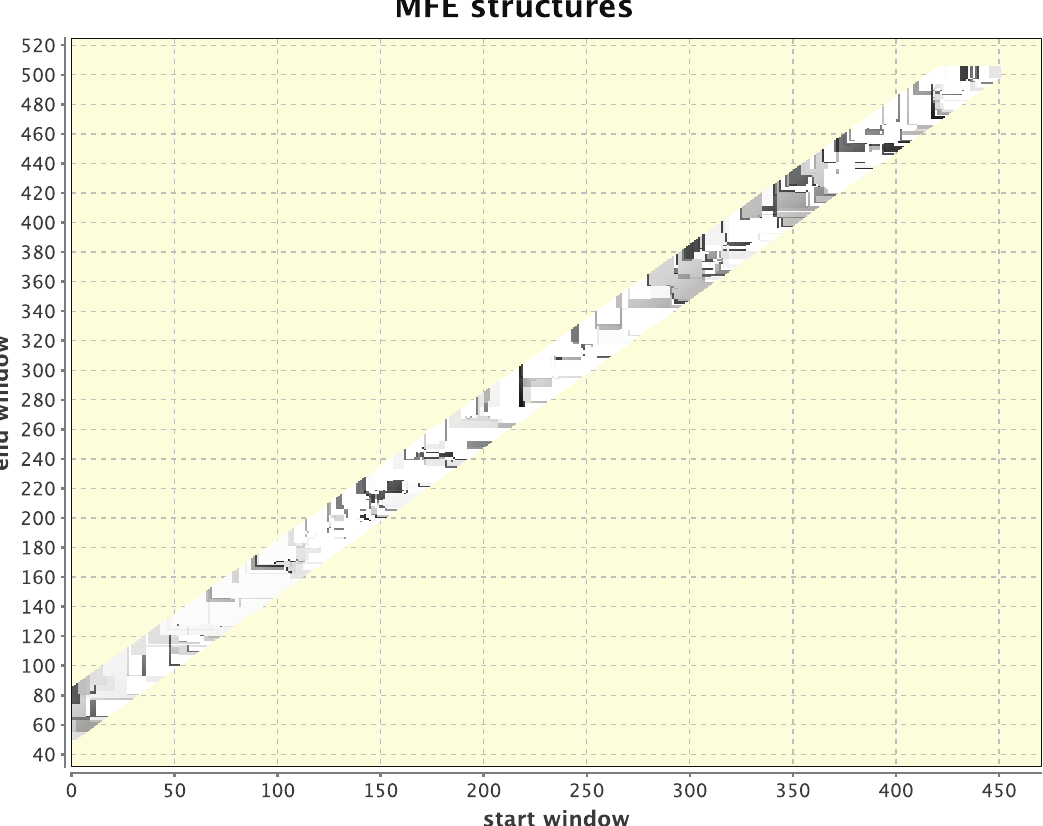
Figure 2. Simulated heat-shock response for drosophilamelanogaster HSP70 Aa. Parameter values are: windows: 55–80, temperatures: 25 u C and 40 u C. Sequence size is 503 nt. In inspecting the graphical plot, a significant cluster of RNA structural activity occurs at segments around 300 and 350, indicating a signal for a potential RNA thermometer.